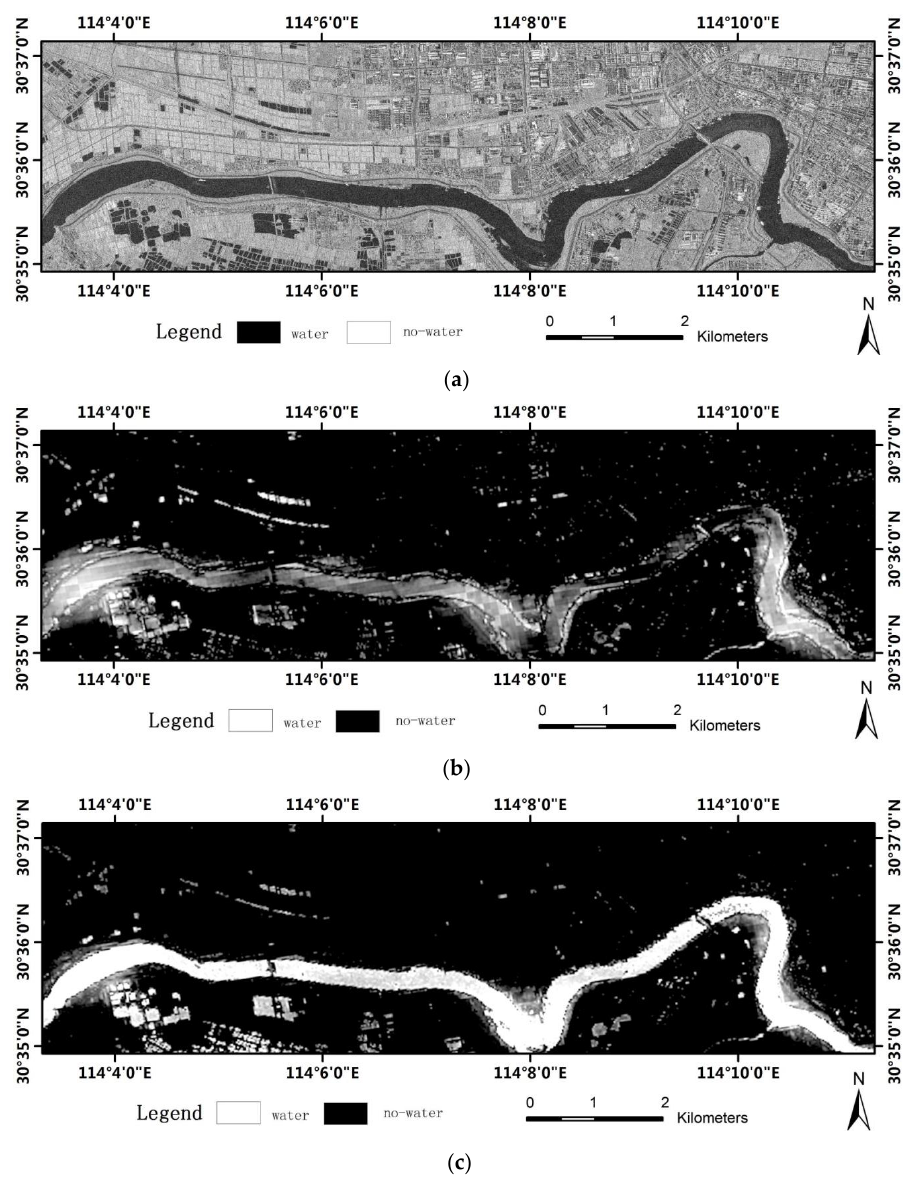
Figure 5. Saliency map comparison (Hanjiang River). ( a ) Original imagery; ( b ) Salience map generated by Itti model; ( c ) Salience map generated by our